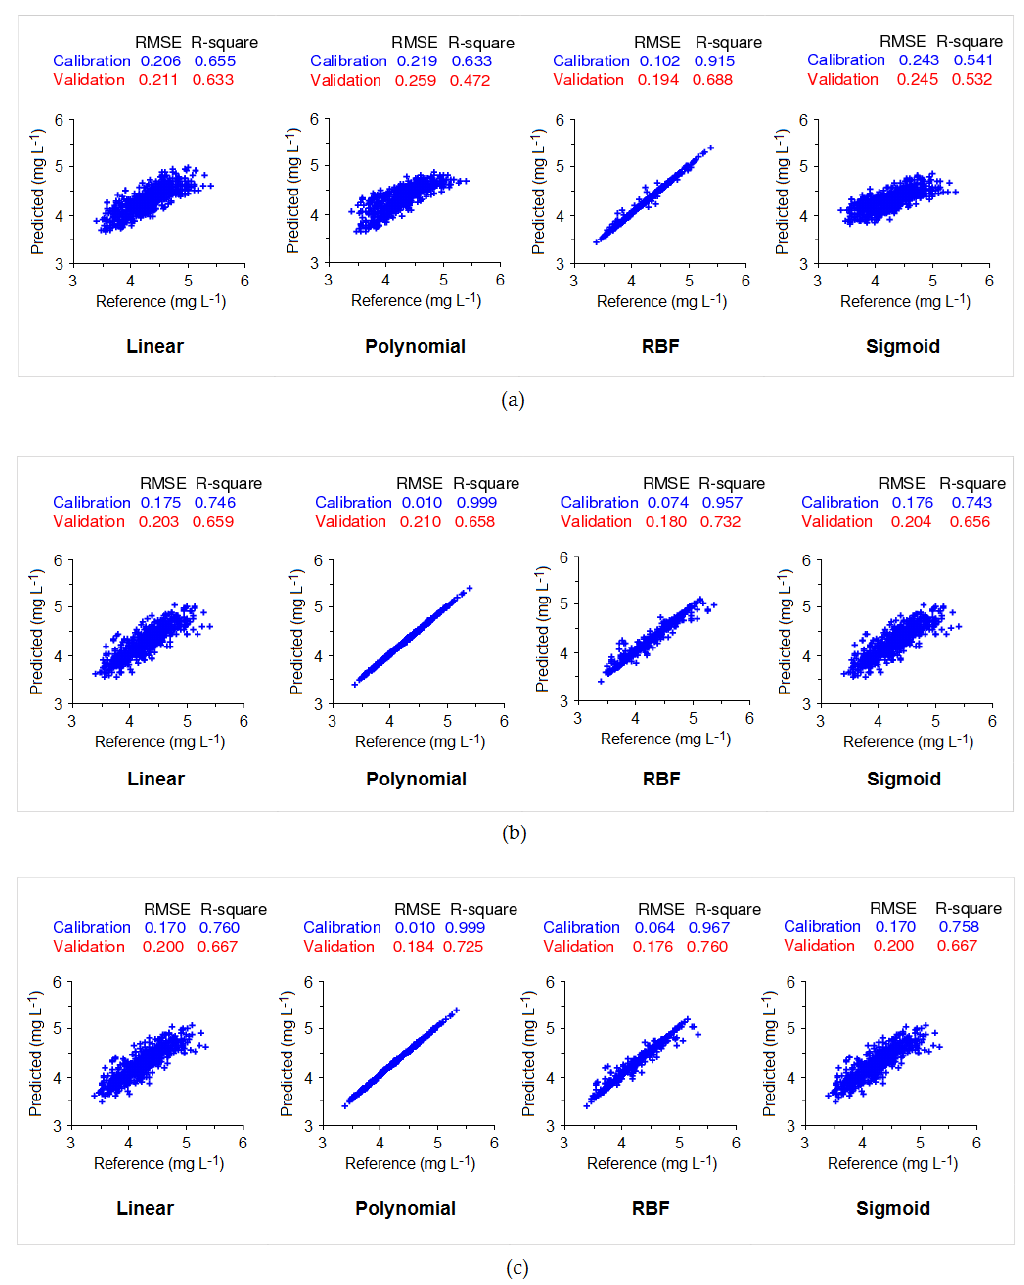
Figure 10. Support vector regression (SVR) performance in model training for different kernel functions: ( a ) Uncompensated spectra ( b ) Particle compensated spectra; and ( c ) particle, organic, and nitrate compensated spectra.